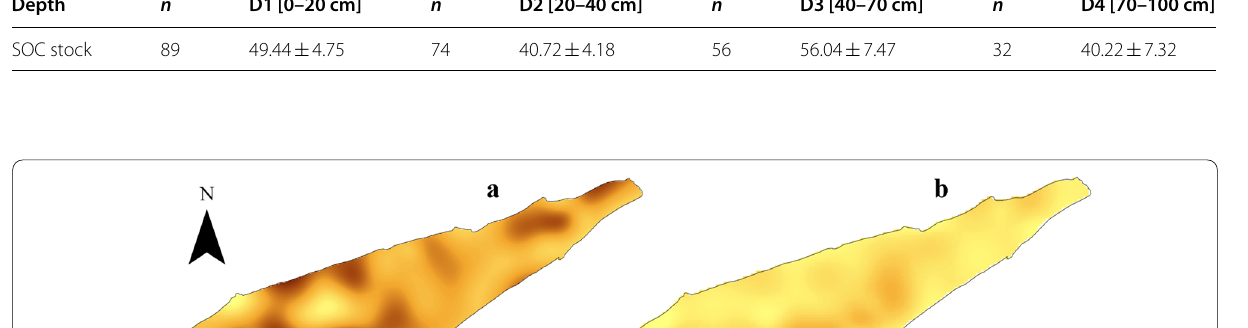
Table 2 Mean SOC densities (Mg ha − 1 ) with standard error ( WIZ. n number of samples collected at varying core-depths =